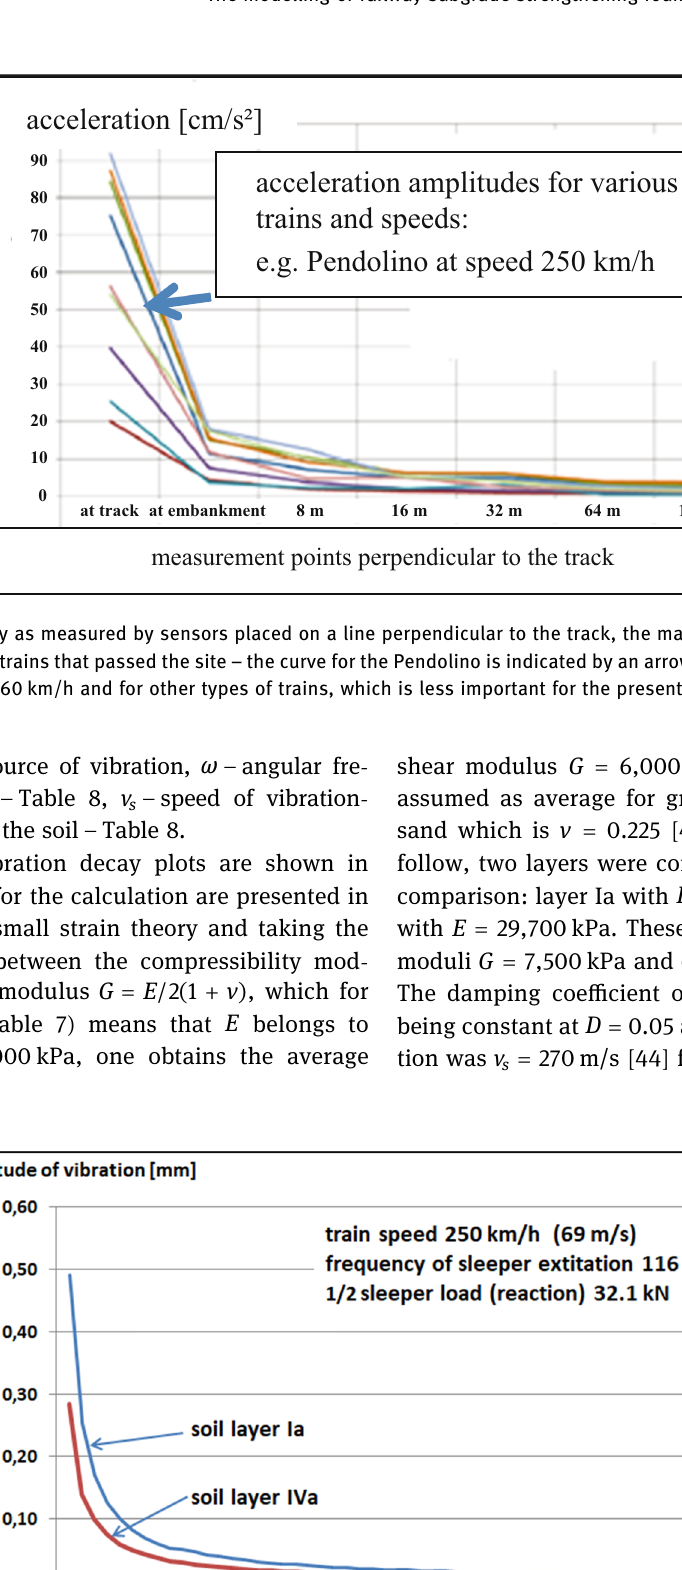
Figure 16: Dependence of the vibration amplitude on the distance from the source ( sleeper bottom ) on the basis of ref. [ 44 ] .